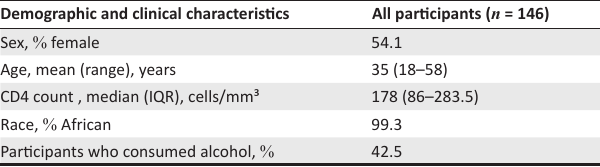
TABLE 1: Baseline characteristics of participants enrolled in the study. Demographic and clinical characteristics